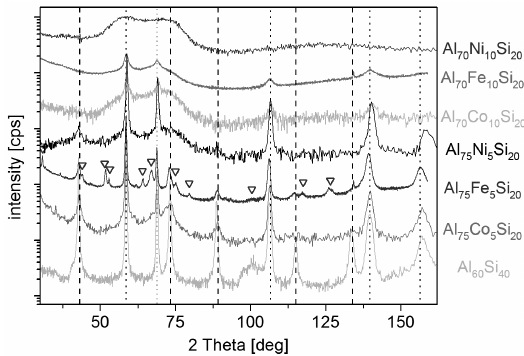
Figure 1. X-ray diffraction patterns of as-quenched alloys. Dotted lines mark fcc-Al phase peaks, dashed lines mark Si phase peaks. Upside-down triangles mark peaks of complex Al-based phases.